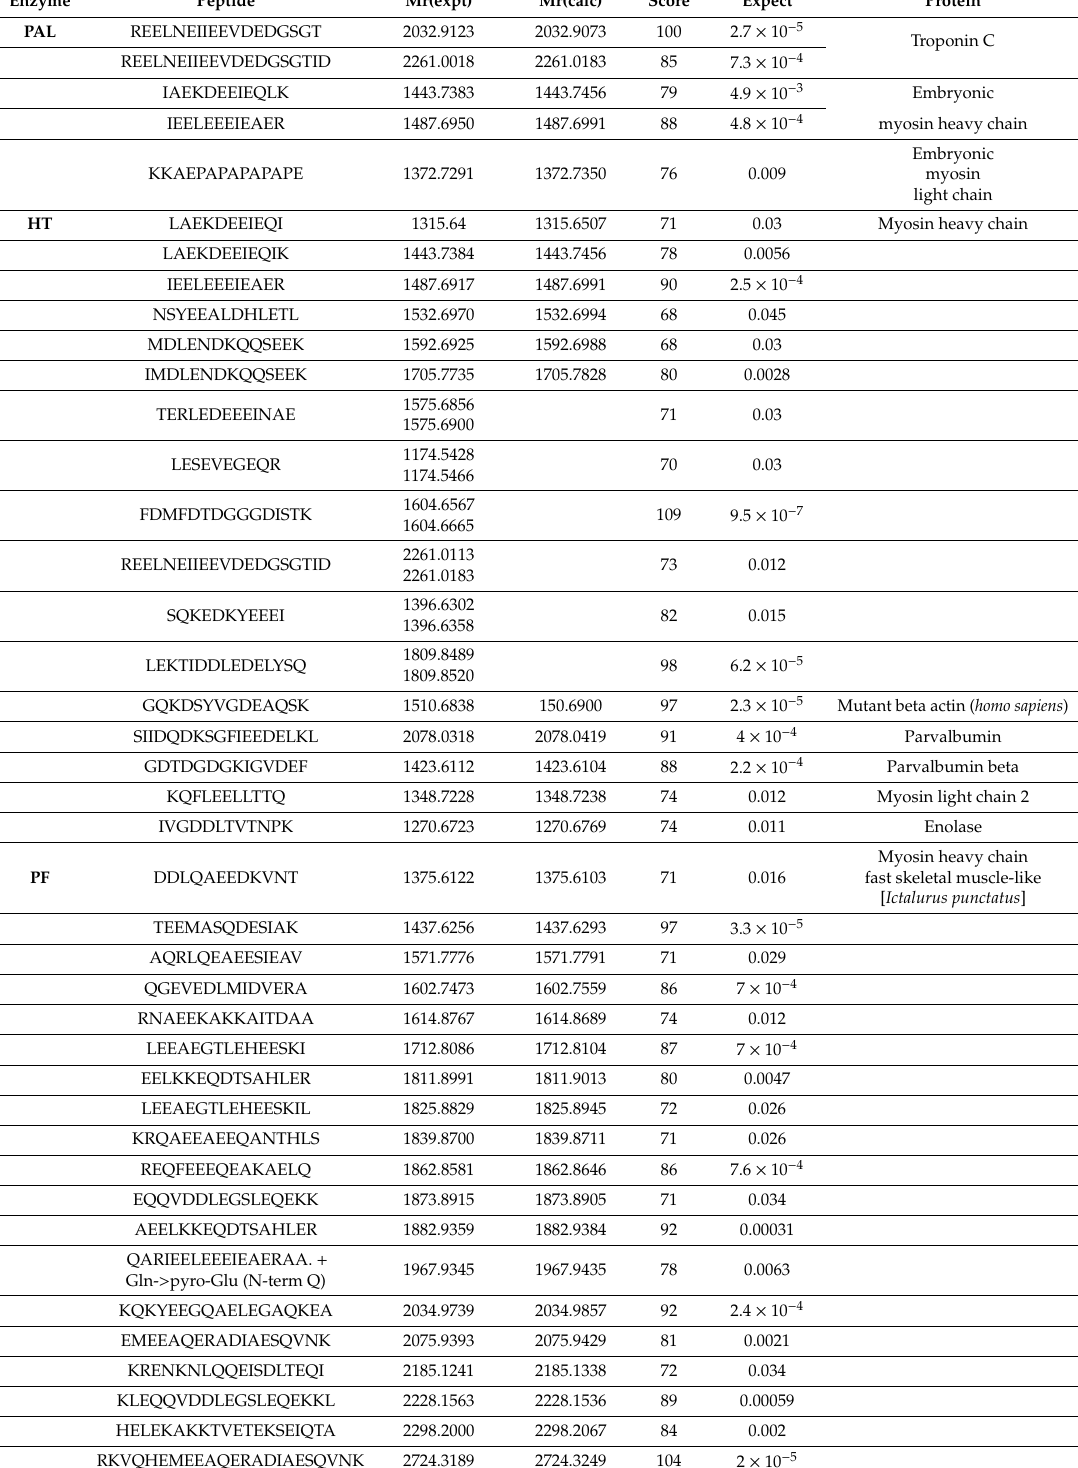
Table 1. Main peptide sequences identified in each of the enzyme’s hydrolysates; Mr(expt) and Mr(calc) are the experimental and calculated theoretical molecular weights; ‘Protein’ is the protein matching that